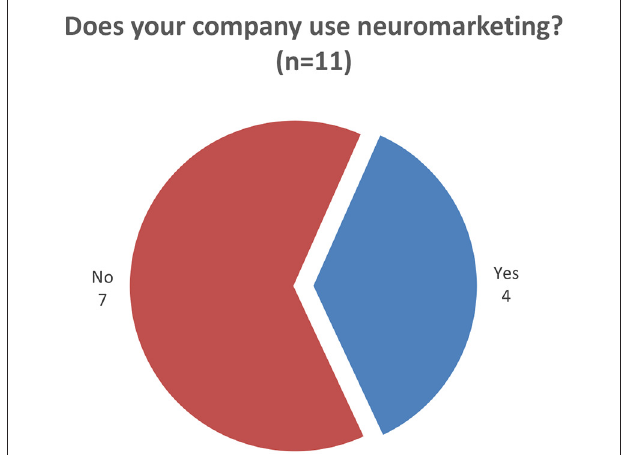
FIGURE 6 | Use of neuromarketing in the company.